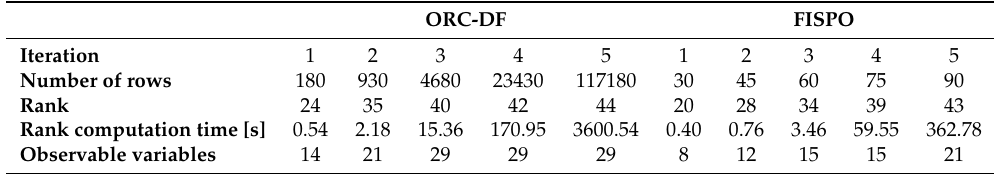
Table 2. Results and computation times of ORC-DF and FISPO for the JAK-STAT